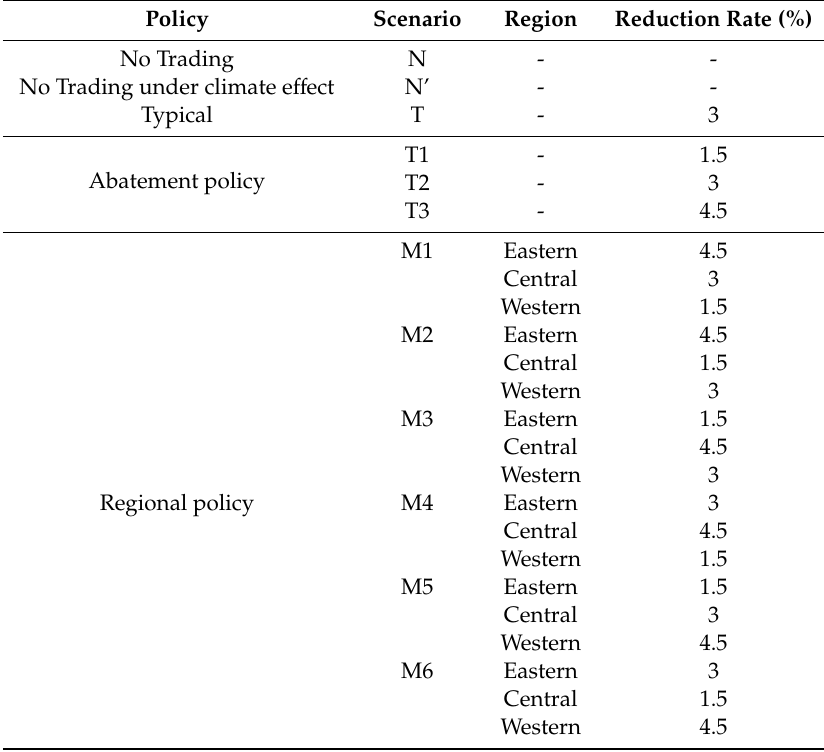
Table 3. Scenarios of multi-region policy